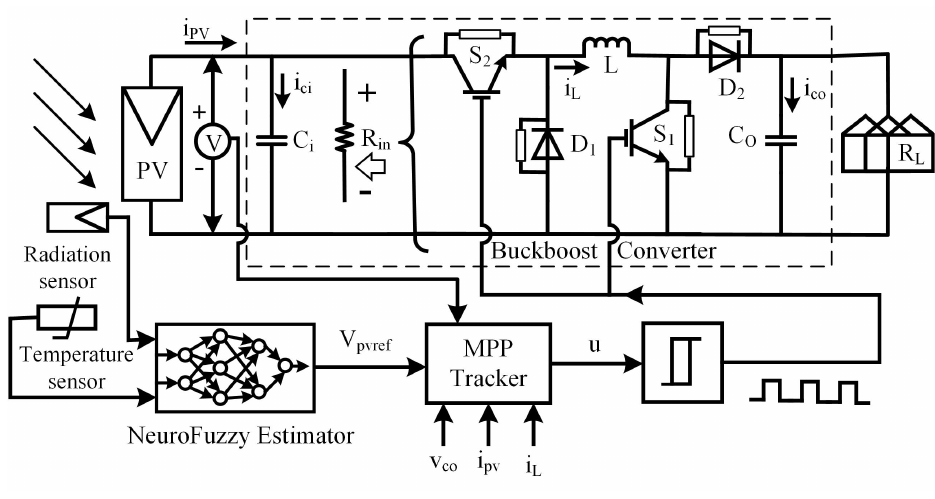
Figure 1. Proposed control